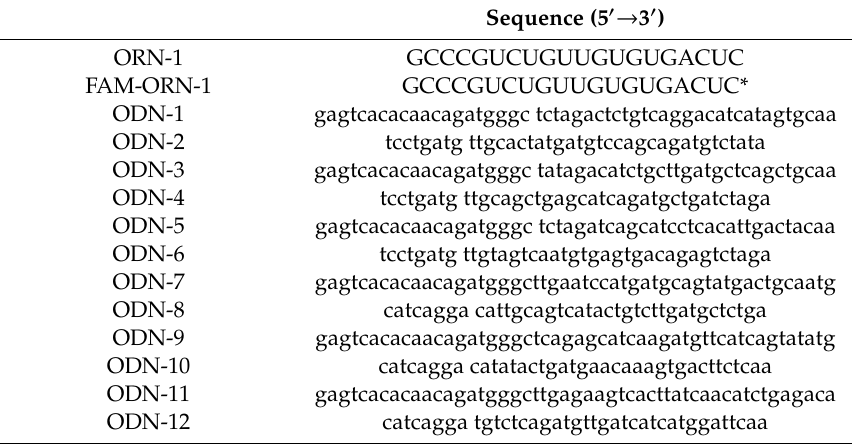
Table 1. Sequences of oligonucleotides used to prepare hexapodRD6. Sequences in capital letters indicate phosphorothioate modification of the inter-nucleotide linkage. The asterisk (*) indicates the position of 6-FAM modification. All ODNs are phosphodiester linkages.